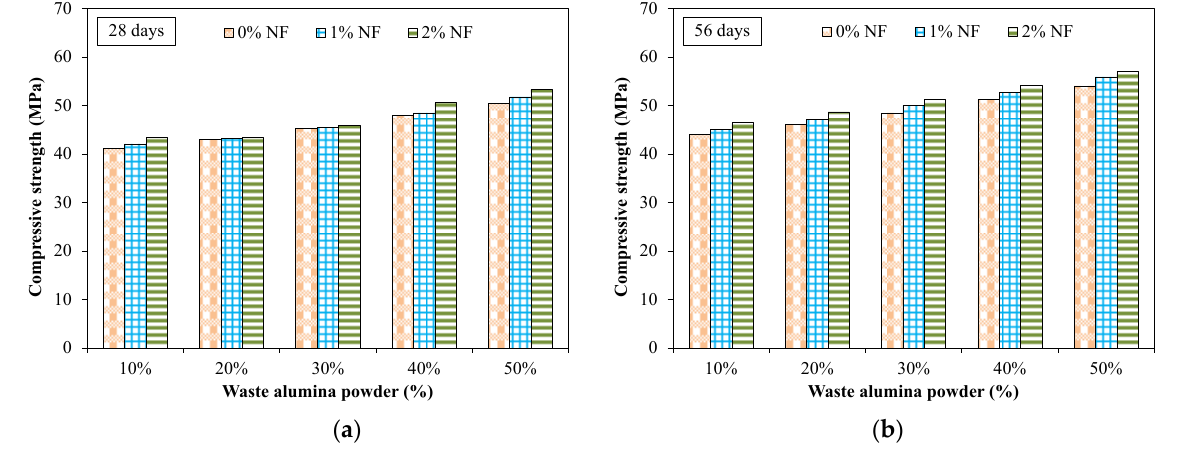
Figure 9. Effect of fibers on compressive strength for specimens incorporating AP. ( a ) 28 days ( b ) 56 days.